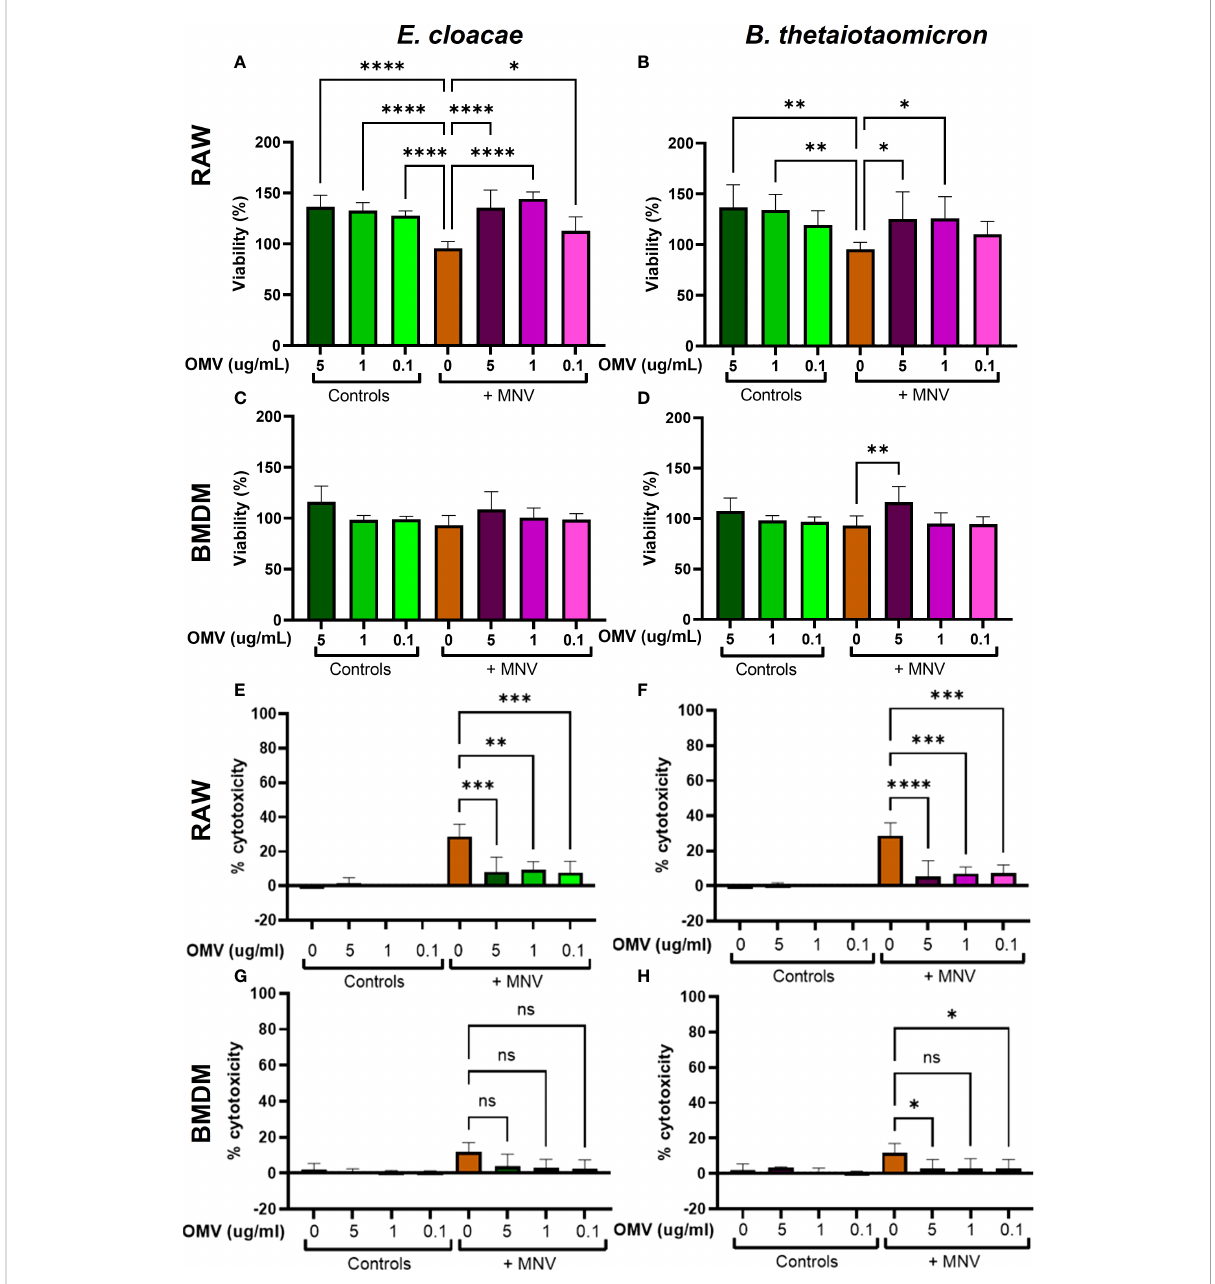
FIGURE 4 Viability and cytotoxicity of macrophages after infection with OMVs and MNV. RAW264.7 and BMDM cells were treated with mock virus, OMVs only, MNV only, or MNV+OMV. Cell viability of RAW264.7 cells (A, B) and BMDMs (C, D) was measured 18 hours post-infection with using MTS assay. Cell cytotoxicity as measured by LDH release was also measured at 18 hours post-treatment for RAW264.7 cells (E, F) and BMDMs (G, H) using spectrophotometry. One-way ANOVA was used to determine statistical signi fi cance. (n=3 for all experiments; *=p<0.05, **=p<0.01, ***=p<0.001, ****=p<0.0001). Ns= not signi fi